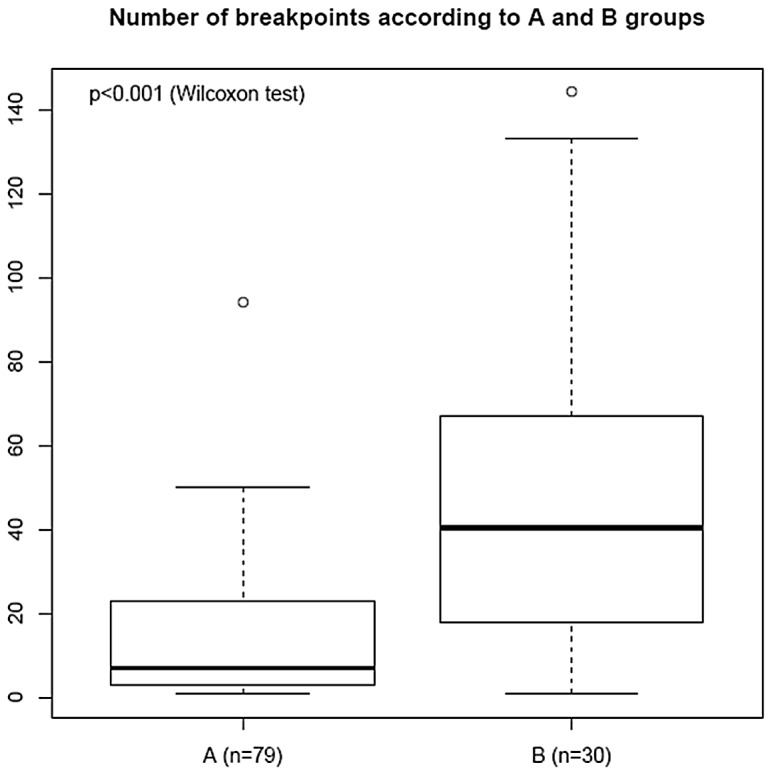
Boxplot of the number of breakpoints within groups A and B from the training set.The black line represents the breakpoints median values (median = 7 in A group; median = 40.5 in B group). The bottom and top of the boxes represent the 25th and 75th percentile respectively, whereas the box represents the interquartile range. The whiskers extend to the most extreme data point which is no more than 1.5 times the interquartile range from the box. The single point at the top of each boxplot represents the maximum number of breakpoints within each group A and B respectively.